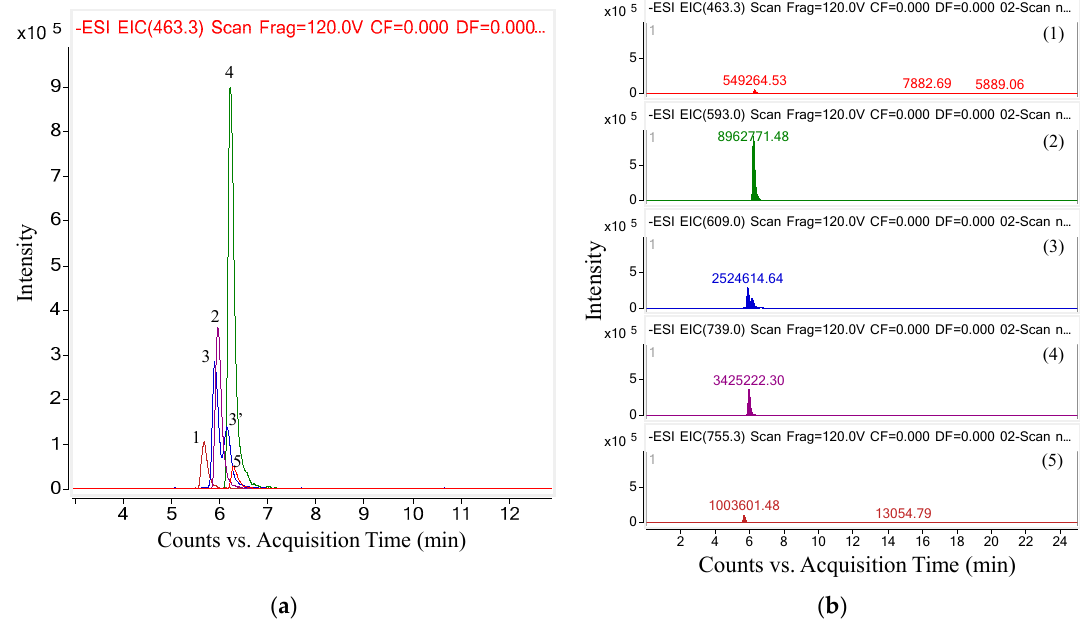
Figure 8. UPLC-MS/MS profile of five anthocyanins found in butterfly pea flower ( a ) and the comparison of their intensity ( b ). ( 1 ) Delphinidin-3-(6”-p-coumaroyl)-rutinoside, ( 2 ) Cyanidin 3-(6”-p-coumaroyl)-rutinoside, ( 3 ) Delphinidin-3-(cis-p-coumaroyl-glucoside), ( 3 ′ ) Delphinidin-3-(trans-p-coumaroyl-glucoside), ( 4 ) Cyanidin-3-(p-coumaroyl)glucose and ( 5 ) Delphinidin-3-pyranoside.